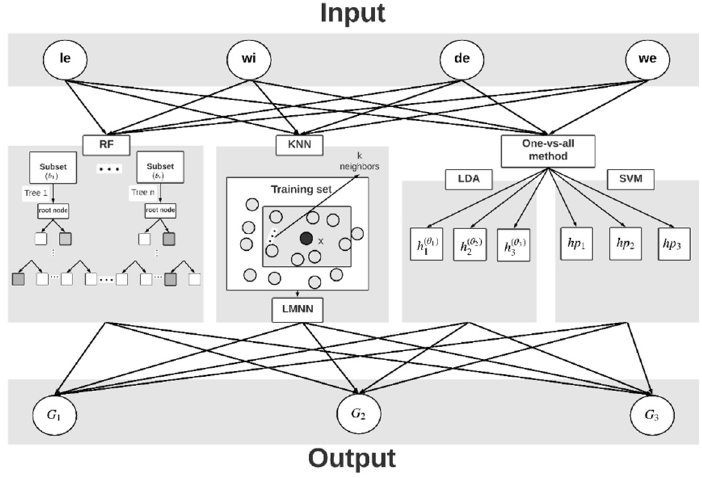
Figure 11. Framework of training process based on models of Support Vector Machine (SVM), Linear Discriminant Analysis (LDA), Random Forest (RF), and K-Nearest Neighbors (KNN). Model RF : in RF model, training data consists of k subset randomly selected with replacement.